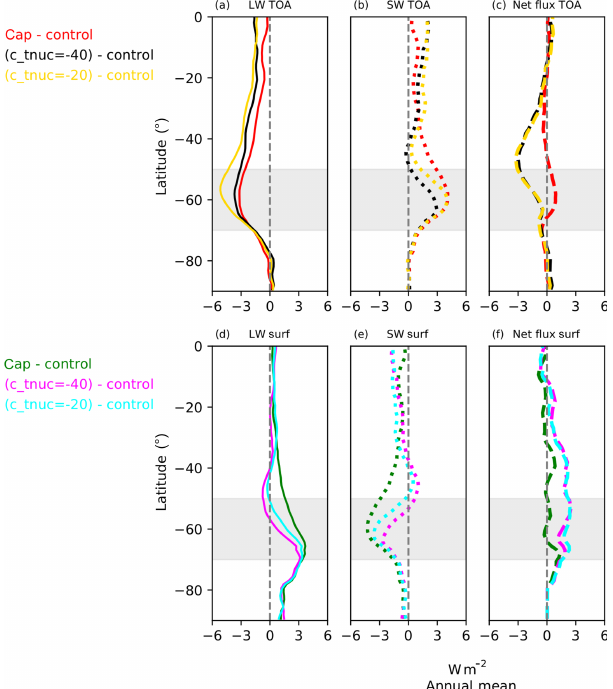
Figure 2. Distribution of zonally averaged annual-mean radiative flux anomalies in various experiments with respect to the control model for the SH. Panels (a–c) represent the TOA (upward) radia- tive flux anomalies and (d–f) represent the surface (downward) flux anomalies. The solid lines in panel (a) indicate LW at TOA; dotted lines in panel (b) indicate SW at TOA, and dashed lines in panel (c) indicate net flux at TOA (i.e. LW plus SW at TOA). Colour codes for TOA fluxes are as follows: red indicates cap minus control; black indicates ( c_tnuc=-40 ) minus control; and yellow indicates ( c_tnuc=-20 ) minus control. Similarly, the solid lines in panel (d) indicate LW at surface, dotted lines in panel (e) indicate SW at sur- face, and dashed lines in panel (f) indicate net radiative heat flux at surf (i.e. incoming LW plus SW at surface minus (sensible heat plus latent heat). Colour codes for surface fluxes are as follows: green indicates cap minus control; magenta indicates ( c_tnuc=-40 ) minus control; and cyan indicates ( c_tnuc=-20 ) minus control. Annual- mean values for model are calculated from daily-mean output over 22 years. The SO region identified in this study is highlighted in